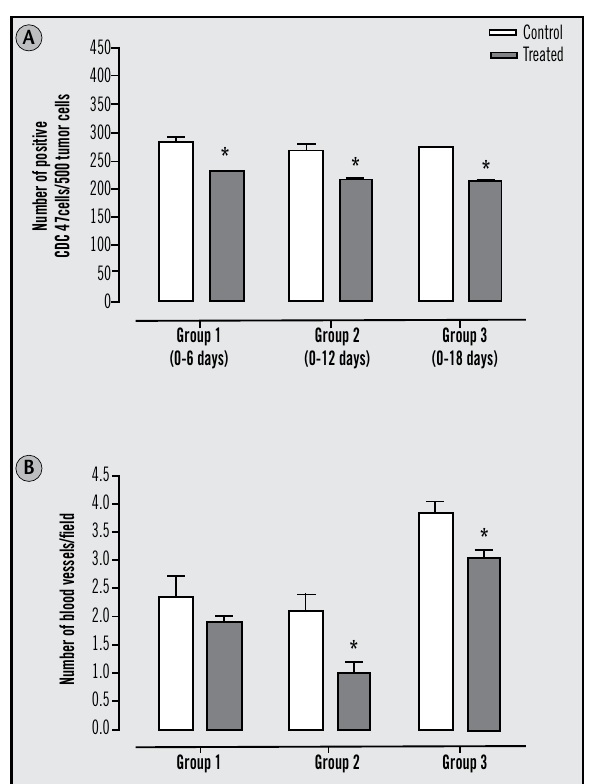
Figure 2 – Number of positive CDC47 tumor cells and number of blood vessels/field (A) Number of positive CDC47 tumor cells in 500 tumor cells. In all treated groups (1, 2 and 3) the number of positive CDC47 tumor cells was decreased relative to their controls. (B) The number of positive CD31 vessels per field (vascular structures) was decreased in tumors of treated groups 2 and 3 compared with control animals. Data represent mean ± SEM (* p < 0.05; t-test) significant difference between the values of control and treated